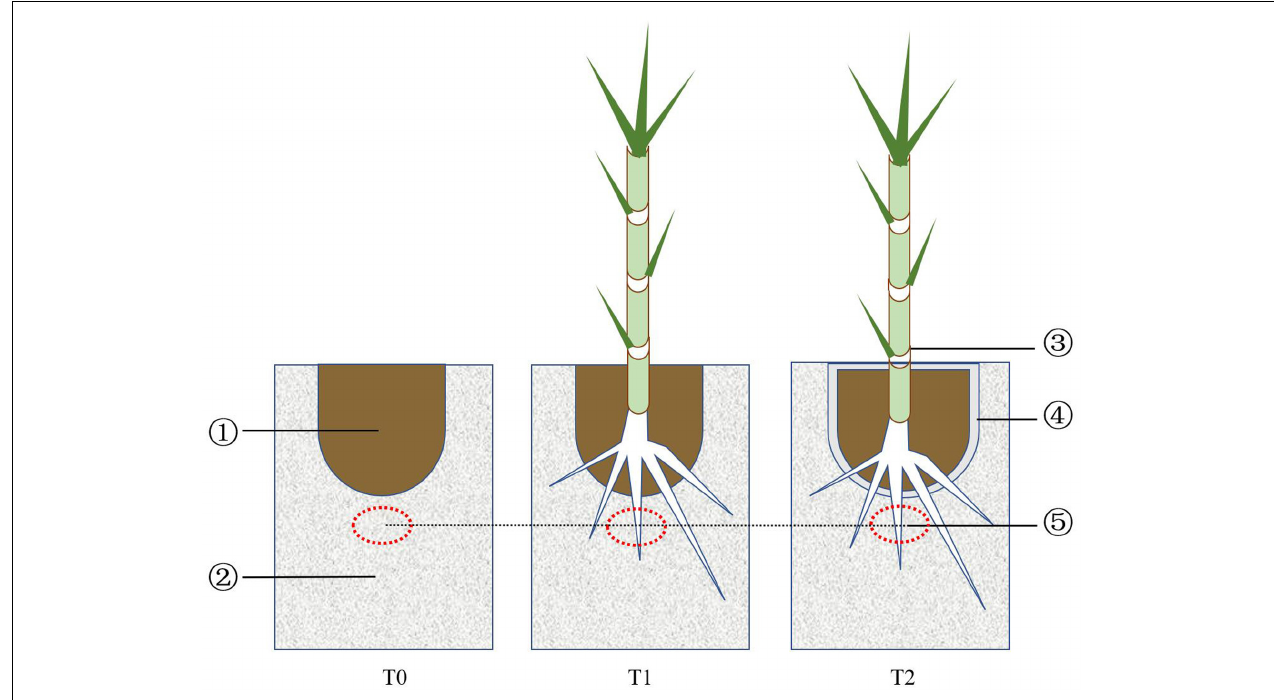
FIGURE 1 | Design of the treatments: (1) soil, (2) iron tailing sand, (3) Pennisetum giganteum seedling, (4) bio-matrix pot, and (5) sampling spot.